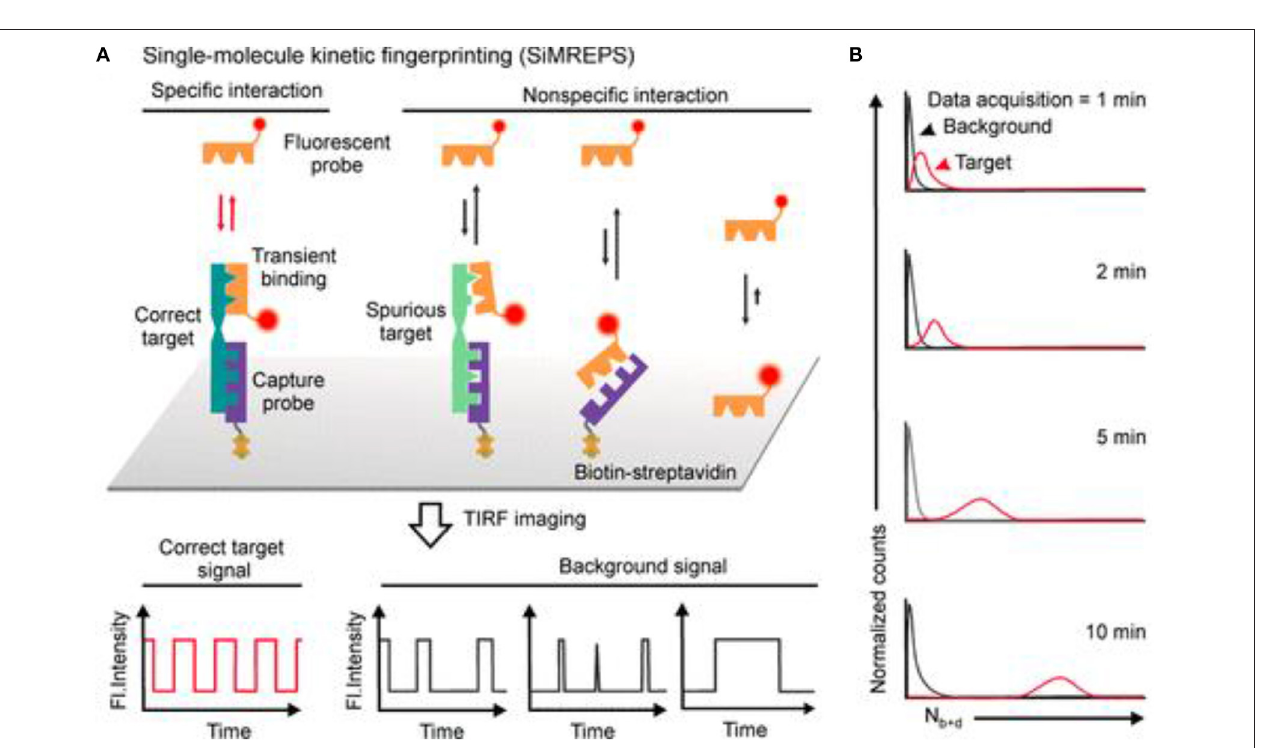
FIGURE 8 | Using SMLM to differentiate specific vs. non-specific effects with PAINT. In SiMREPS, (A) using carefully designed molecular probes, specific interactions are associated with single molecule blinking signals that are homogeneous over time, while non-specific events are seen as heterogeneous blinking events. (B) Over time, better separation between specific and non-specific events are expected (Mandal et al., 2020). Copyright with permission from the American Chemical